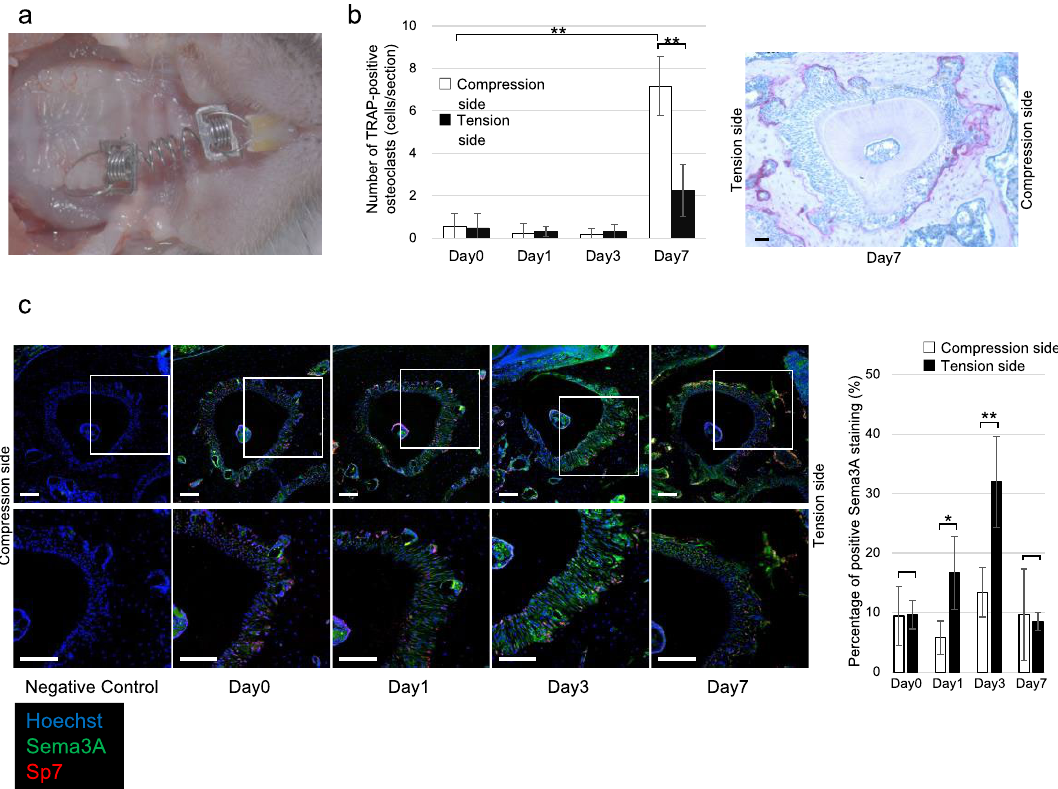
Figure 1. ( a ) Experimental model of orthodontic tooth movement (OTM). ( b ) Number of osteoclasts in the first molar palatal root region on compression and tension sides after OTM (n = 4) and TRAP staining of day 7. The number of osteoclasts was significantly increased on the compression side on day 7 and also a significant increase on the compression side compared to the tension side on day 7. Data are presented as the mean ± SD. * p < 0.05; ** p < 0.01. Scale bars = 50 µm. ( c ) Immunofluorescent staining of Sema3A and Sp7 in the palatal roots. On day 1 and 3, more Sema3A was observed on the tension side than on the compression side (n = 5). Blue, Hoechst; Green, Sema3A; Red, Sp7. Data are presented as the mean ± SD. * p < 0.05; ** p < 0.01. Scale bars = 100